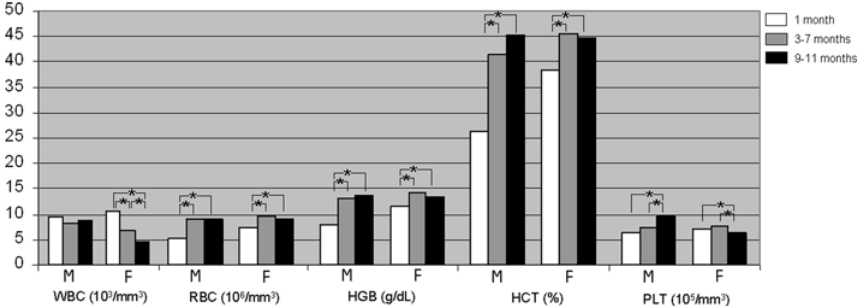
Figure 4. Hematological median values in female and male mice. Age related hematological median values calculated in C57BL/6J mouse strain (M=males; F=females). Statistical significant differences among values observed in the three age-period (1/ 3–7/ 9–11 months) are also indicated: * p , 0.05.